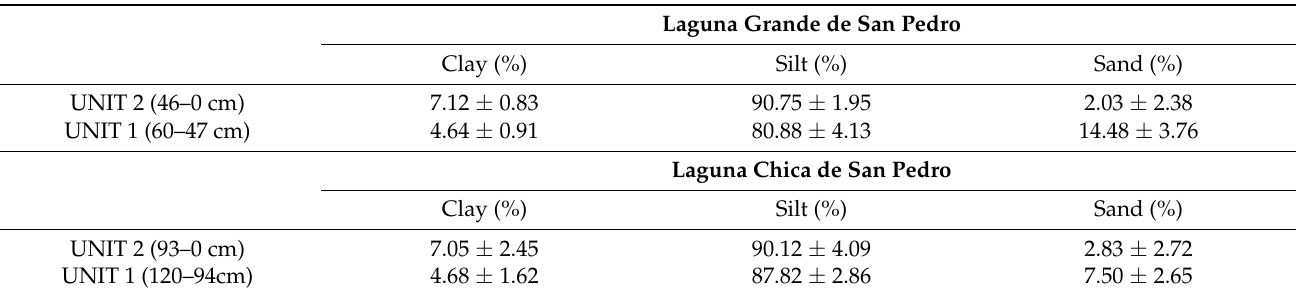
Figure 3. Depth profiles of magnetic susceptibility (SI), organic matter (%), biogenic silica (%), TOC (weight %), C/N ratio atomic, δ 13 C (‰) and δ 15 N (‰) in sediment core of ( a ) Laguna Grande de San Pedro (LGSP) and ( b ) Laguna Chica de San Pedro (LCSP). Table 3. Composition of the sediment grain-size (mean percentage ± standard deviation) of the Laguna Grande (LGSP) and Laguna Chica de San Pedro (LCSP) described by lithological units.